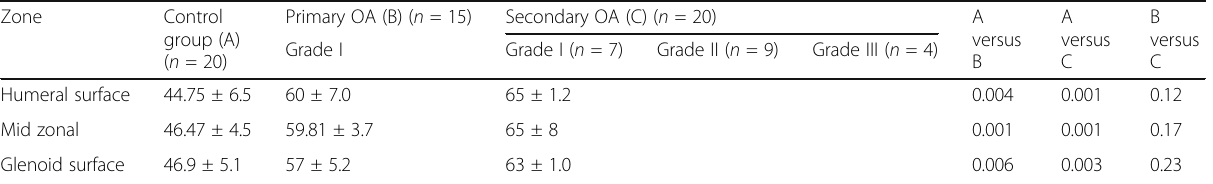
Table 1 Mean T2 mapping values at three original sites with a comparison of the values Zone